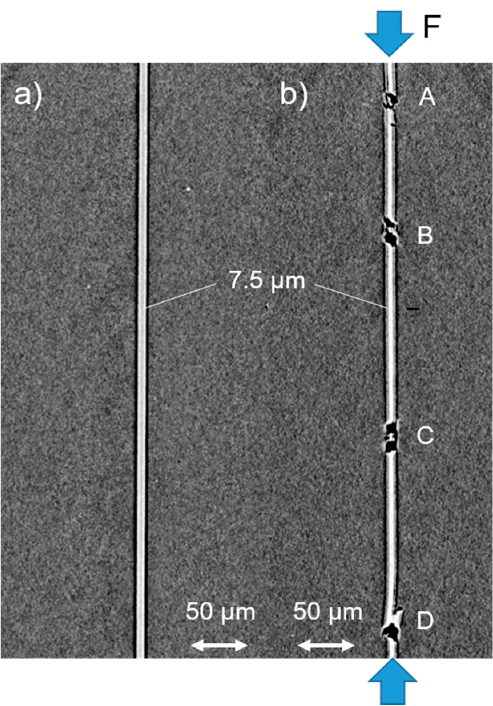
Figure 4. Post mortem X-ray projections of two Broutman test specimens taken under identical settings: ( a ) nonloaded and ( b ) preloaded. The C-fiber is clearly visible in the toughened polymeric matrix, additionally the in-line phase contrast artefacts are visible in both projections as a distinct black line at both sides of the fiber. A, B, C, D mark the locations of fiber fracture with two fracture planes each and a small fracture piece in between them. The blue arrows highlight the direction of force applied during tests (compression).